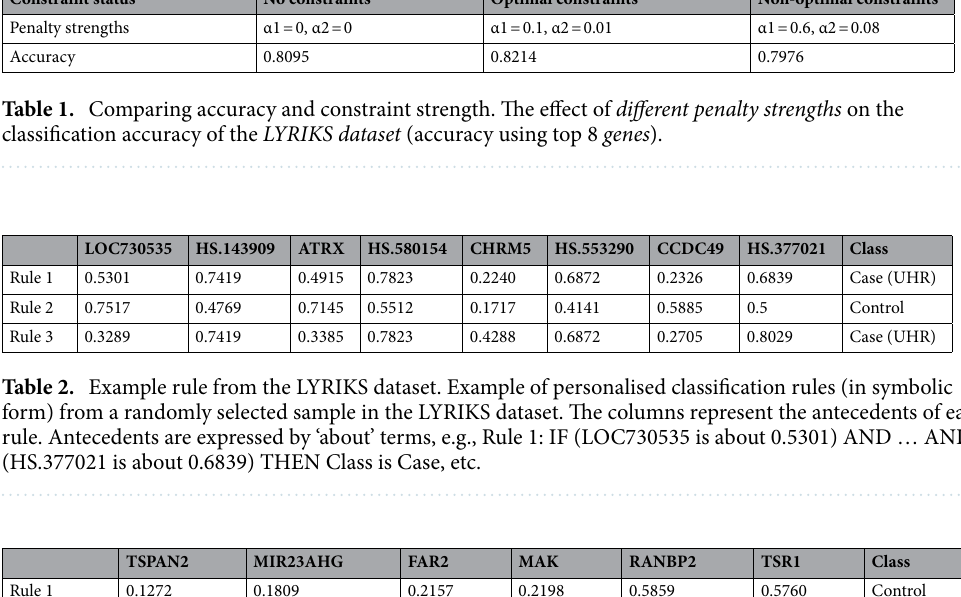
Constraint status No constraints Optimal constraints Penalty strengths